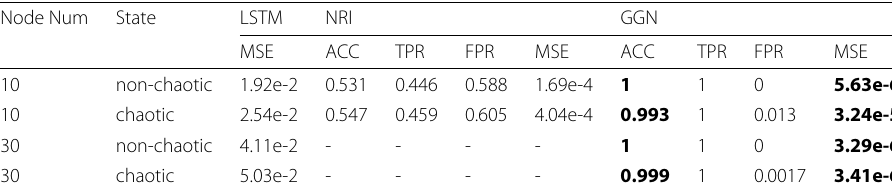
Table 2 Results with CML model